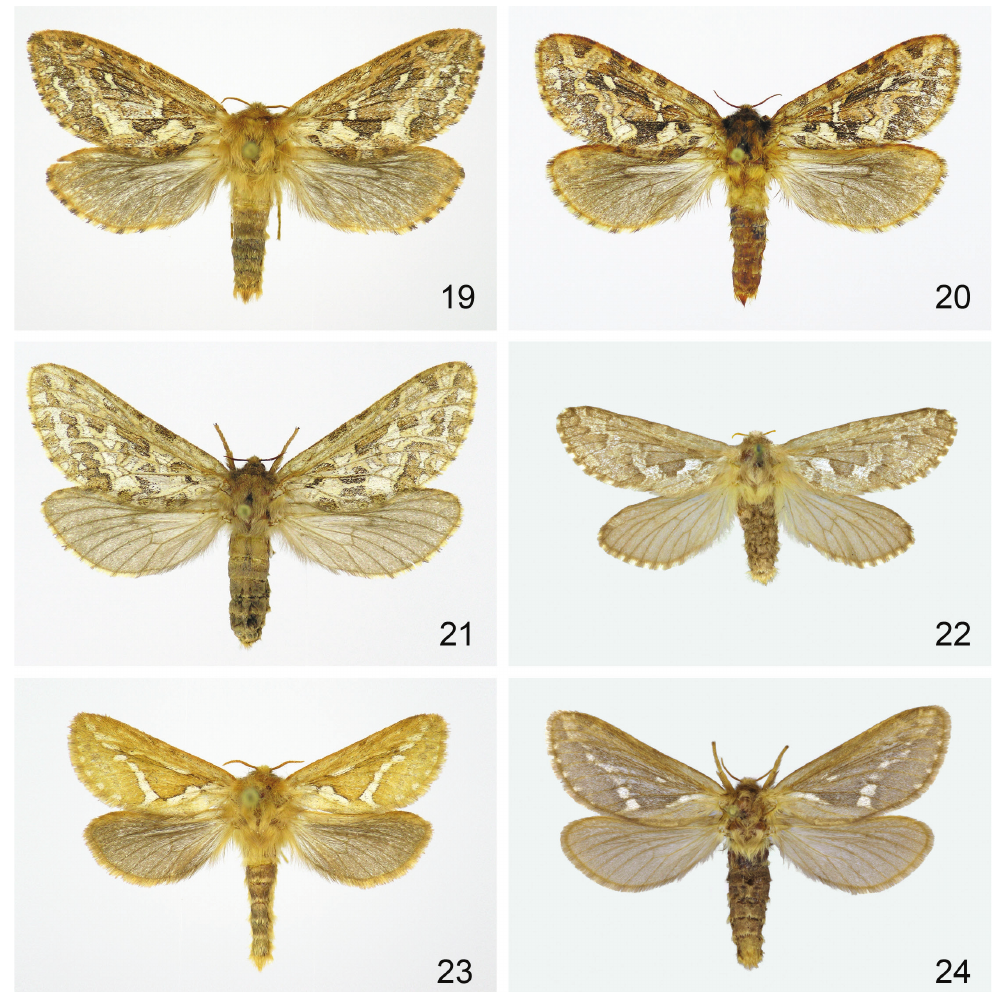
markings on its forewing, which are not distinctly edged or embedded into light brown scales, and by the presence of a dirty yellow patch subapically at the forewing costa. Males have 25–27 antennal segments (Buser et al. 2000). Females of P. anselminae are brachypterous. Pharmacis claudiae (Fig. 18) has extensive and evenly distributed white markings on the forewings (reduced in P. cantabricus sp. n.) and the hindwing fringe is white, somewhat mixed with dark brown at the veins. Males have 26–28 antennal segments (Buser et al. 2000). Females of P. claudiae are fully winged and able to